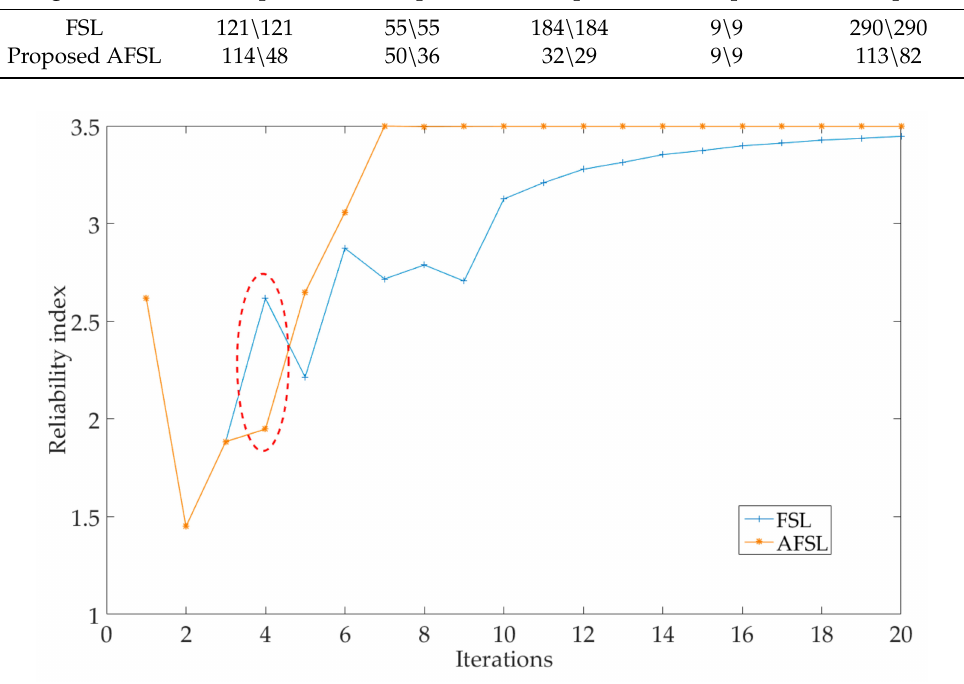
Figure 11. The comparisons of iterative process for Example 3.